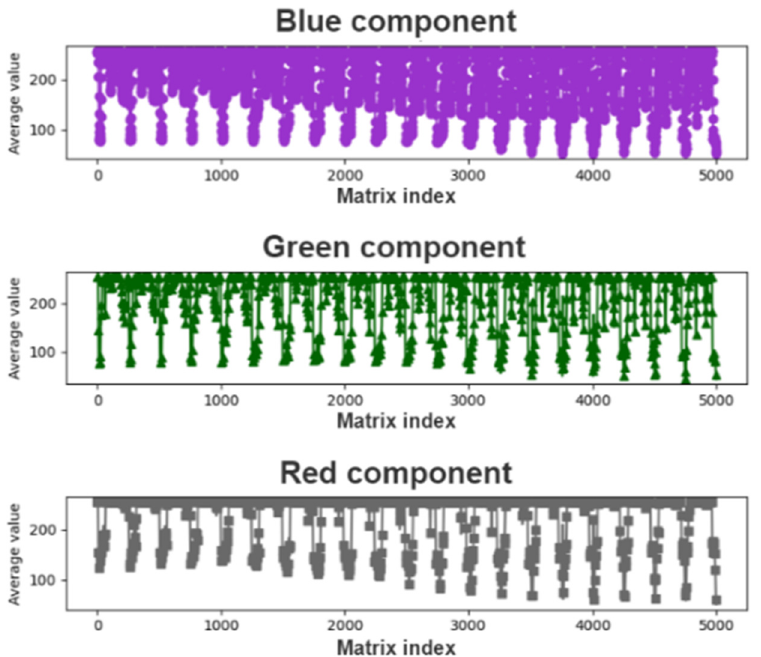
Figure 14. Graph of the extraction interval.